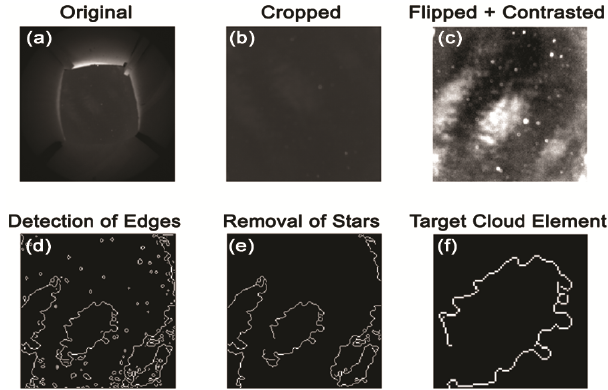
Figure 3. Various processing steps involved in identifying the tar- get cloud. (a) The original image having 512 × 512 pixels, (b) the cropped image having 256 × 256 pixels, (c) the image corrected for geometric coordinates and later enhanced using the gray-level his- togram method, (d) the contours of high intensity identified by using the Canny method of edge detection, (e) the cleaned cloud image af- ter the removal of stars and noisy structures and (f) the target